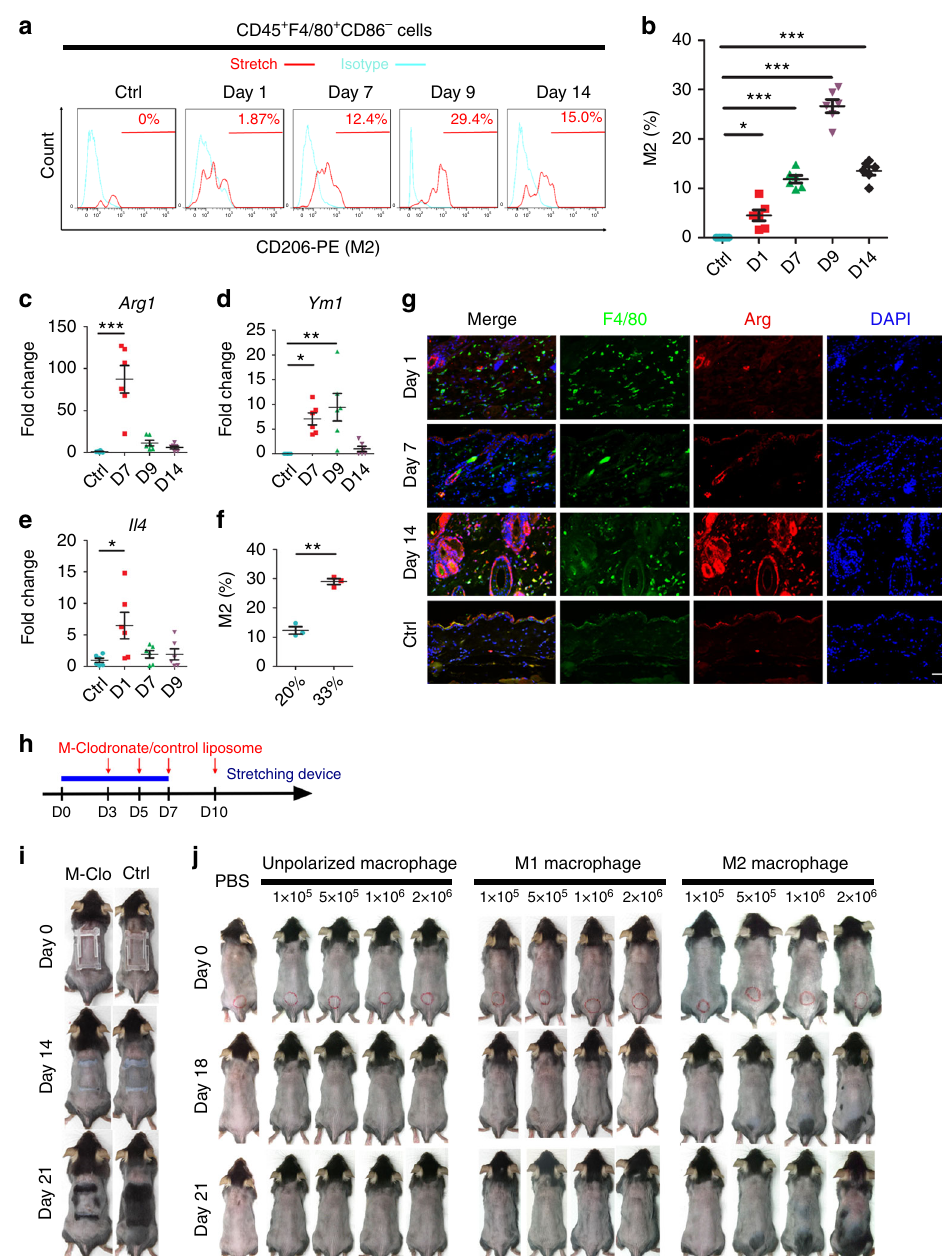
Fig. 5 M2 polarization induced by strain alteration is crucial for regeneration. a , b Representative FACS histograms ( a ) and quanti fi cation ( b ) of the percentages of CD45 + F4/80 + CD206 + CD86 - M2 macrophages activated in response to stretch (day 1 and day 7) and release of stretch (day 9 and day 14); n = 6 for each group. c – e Real-time PCR for Arginase-1 (Arg1) ( c ), Ym1 ( d ), and Il4 ( e ) in response to stretch (day 1 and day 7) and release of stretch (day 9 and day 14); n = 6 for each group. f Quanti fi cation using fl ow cytometry of M2 macrophages in response to 20 or 33% strain; n = 3 for each group. g Dual immunostaining of F4/80 and Arginase indicated that double positive M2 macrophages were more conspicuous at day 14. h Schematic of subcutaneous injection with mannosylated clodronate liposomes (M-Clodronate) to deplete M2 macrophages. i Stretch-induced hair regeneration was perturbed by mannosylated clodronate liposomes (M-Clo) injection; n = 6 for each group. j Transplantation of unpolarized and polarized M1 or M2 macrophages into the back skin of mice during the telogen phase. Note only M2 macrophages caused hair regeneration, and the intensity of hair growth was proportional to the number of transplanted cells. The red circle at day 0 indicates the injection area; n = 6 for each group. Statistical signi fi cance was determined by conducting ANOVA followed by a Bonferroni post hoc test ( b – e ) or Student ’ s two-tailed t -test ( f ). Data are presented as means ±